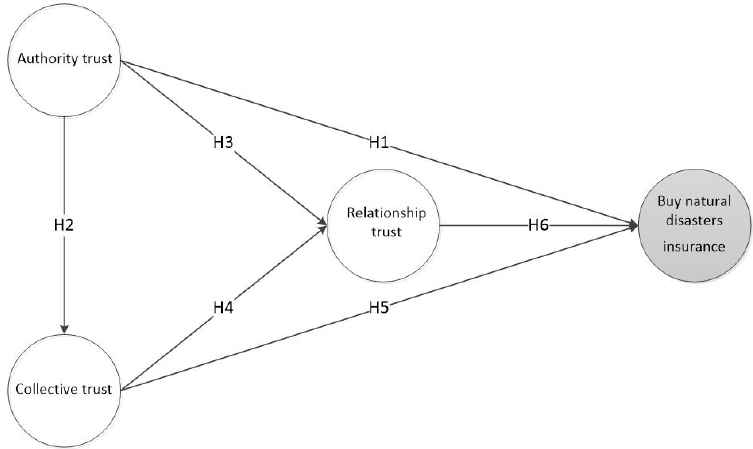
Figure 2. Examining the hypothetical